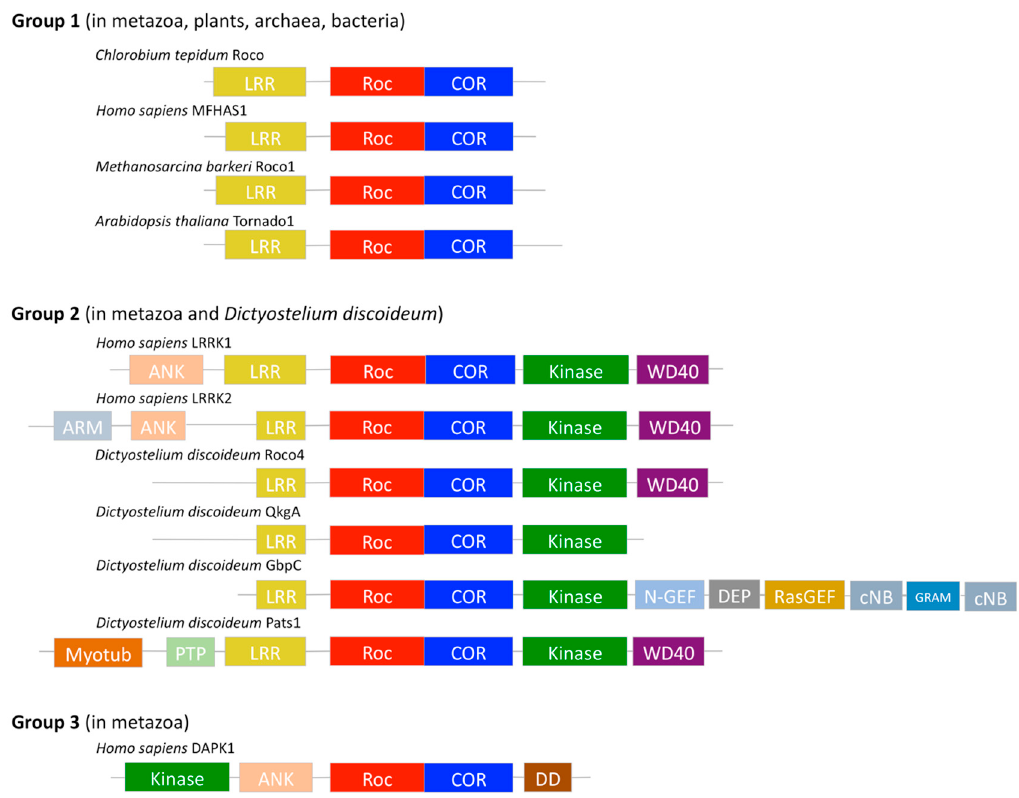
Figure 1. Classification of Roco proteins based on domain topology. Roco proteins are characterized by the presence of a Roc domain (red) and COR domain (blue). Based on their domain topology, Roco proteins can be divided into three groups [29]. Here some representatives of each group are shown. The first group only contains an LRR domain (yellow) preceding the RocCOR. Representatives of this group are found in metazoa, plants, archaea, and bacteria. The second group contains, in addition to this LRR–Roc–COR domain topology, a C-terminal kinase domain (green). Moreover, members of this group contain several protein–protein interaction and regulatory domains like an Ankyrin repeat (ANK, pink), armadillo repeats (ARM, light blue), a N-terminal motif of RasGEF (N-GEF, light blue), a cyclic nucleotide binding domain (cNB, light grey), a Rab-like GTPase activators and myotubularins domain (GRAM, blue), a Ras Guanine Exchange Factor domain (RasGEF, beige), a N-terminal myotubularin-related domain (myotub, orange), a protein tyrosine phosphatase domain (PTP, light green), a Dishevelled domain, and an Egl-10 domain and Pleckstrin domain (DEP, grey). The last group has one human family member, DAPK1. DAPK1 lacks an LRR domain and is characterized by its C-terminal death domain (DD, brown).